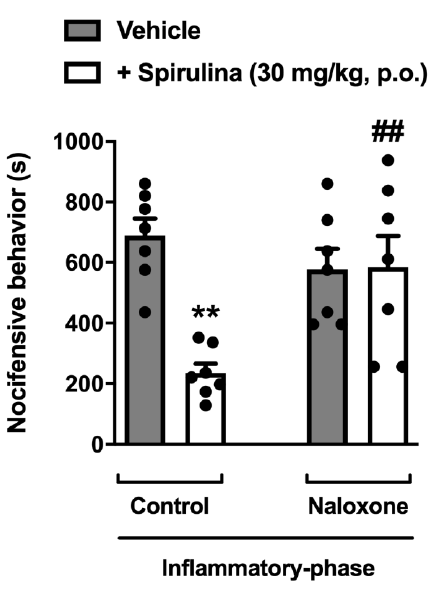
Figure 6. Effect of Spirulina on nociceptive behavior induced by glutamate in mice. Each column represents the mean ± SEM of 11–12 animals/group, with a black dot showing individual mice, using one-way ANOVA.